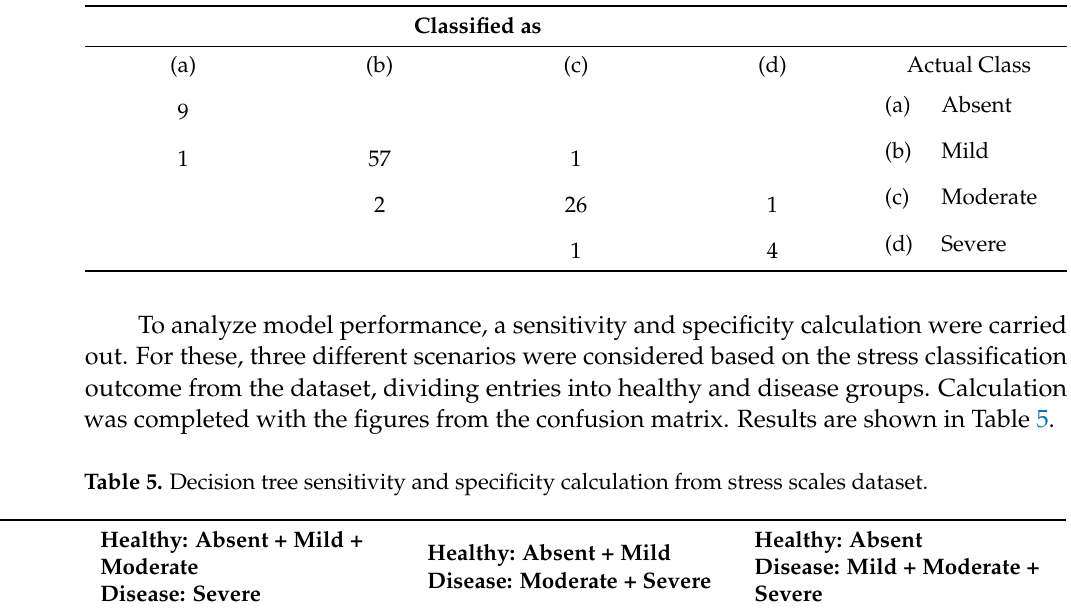
Table 4. Confusion matrix of obtained decision tree model for stress level classification.